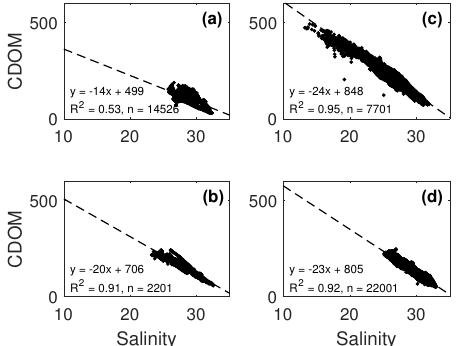
Figure 7. Salinity vs. CDOM fluorescence from M/V Funny Girl for the period between 2012 and 2014 (summer seasons): (a) 2012, (b) before the 2013 flood, (c) during and after the 2013 flood and (d) 2014.